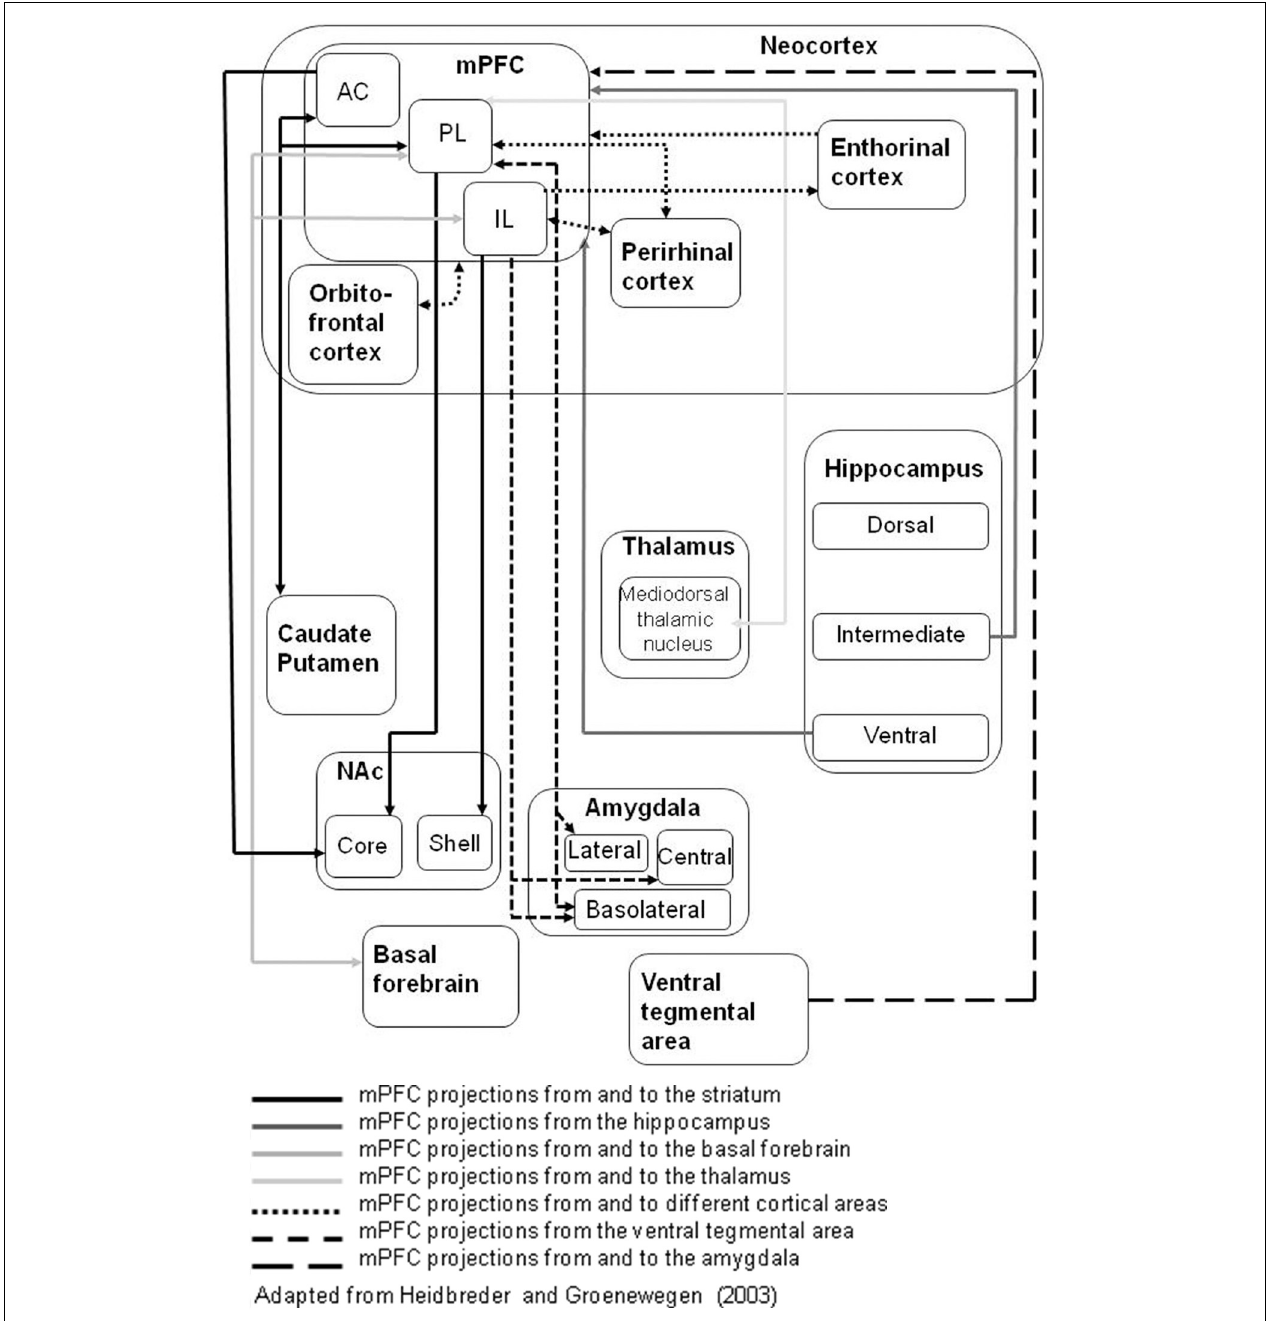
FIGURE 1 | The connections of rat medial prefrontal cortex (mPFC) sub-regions with other key brain regions; based on Heidbreder and Groenewegen (2003). The different arrow line formats (use of dashed and gray lines) denote connections to (and from) different target structures.